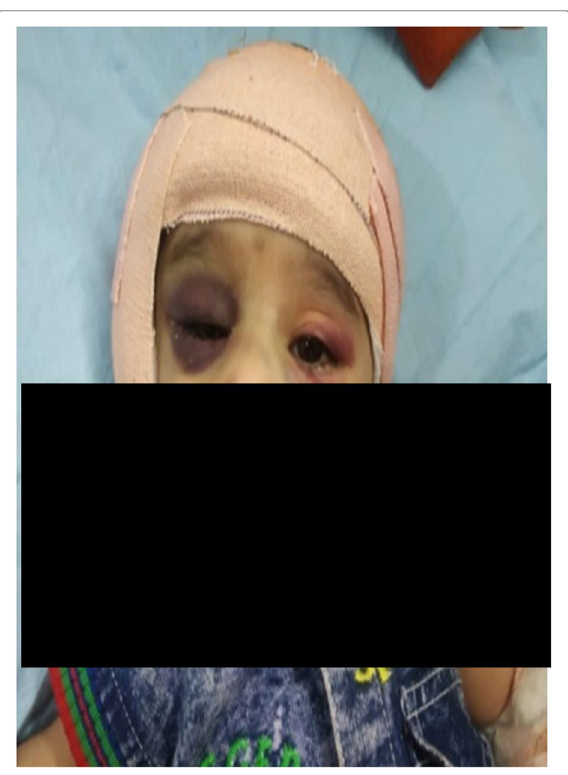
Fig. 2 Child developed bilateral periorbital ecchymosis after 42 h of